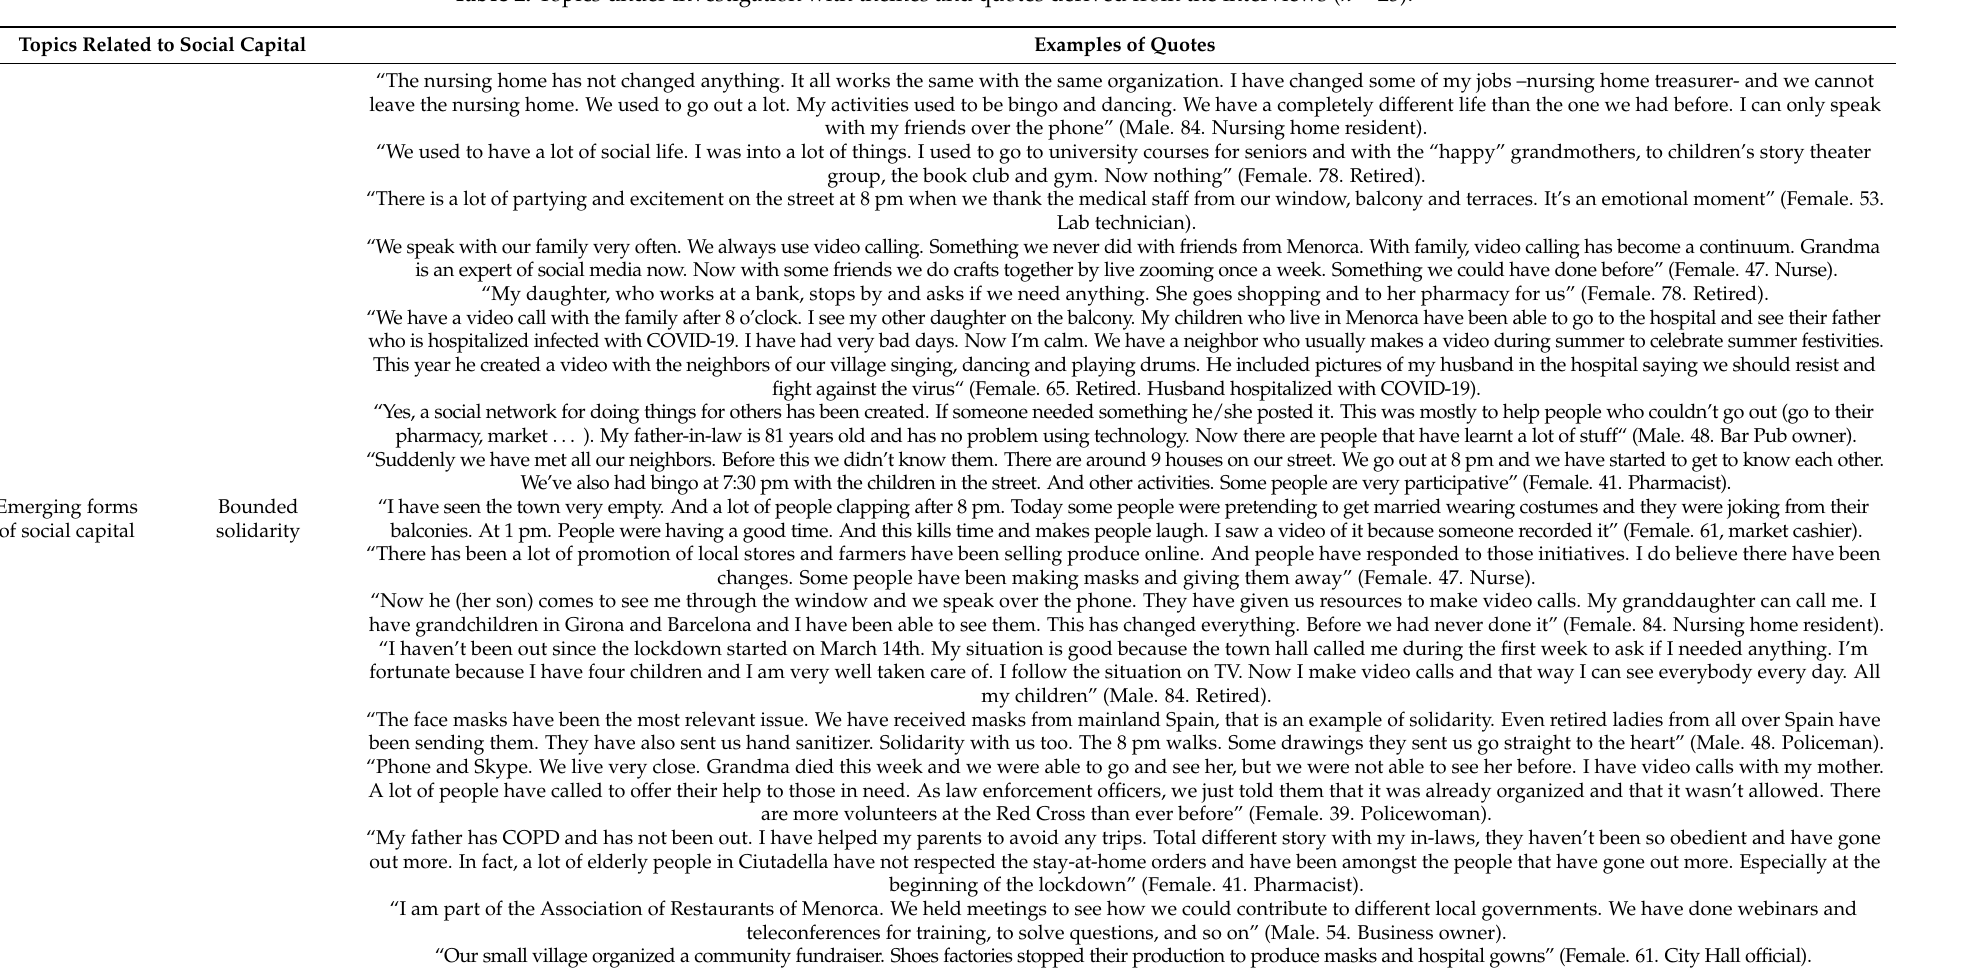
Table 2. Topics under investigation with themes and quotes derived from the interviews ( n =